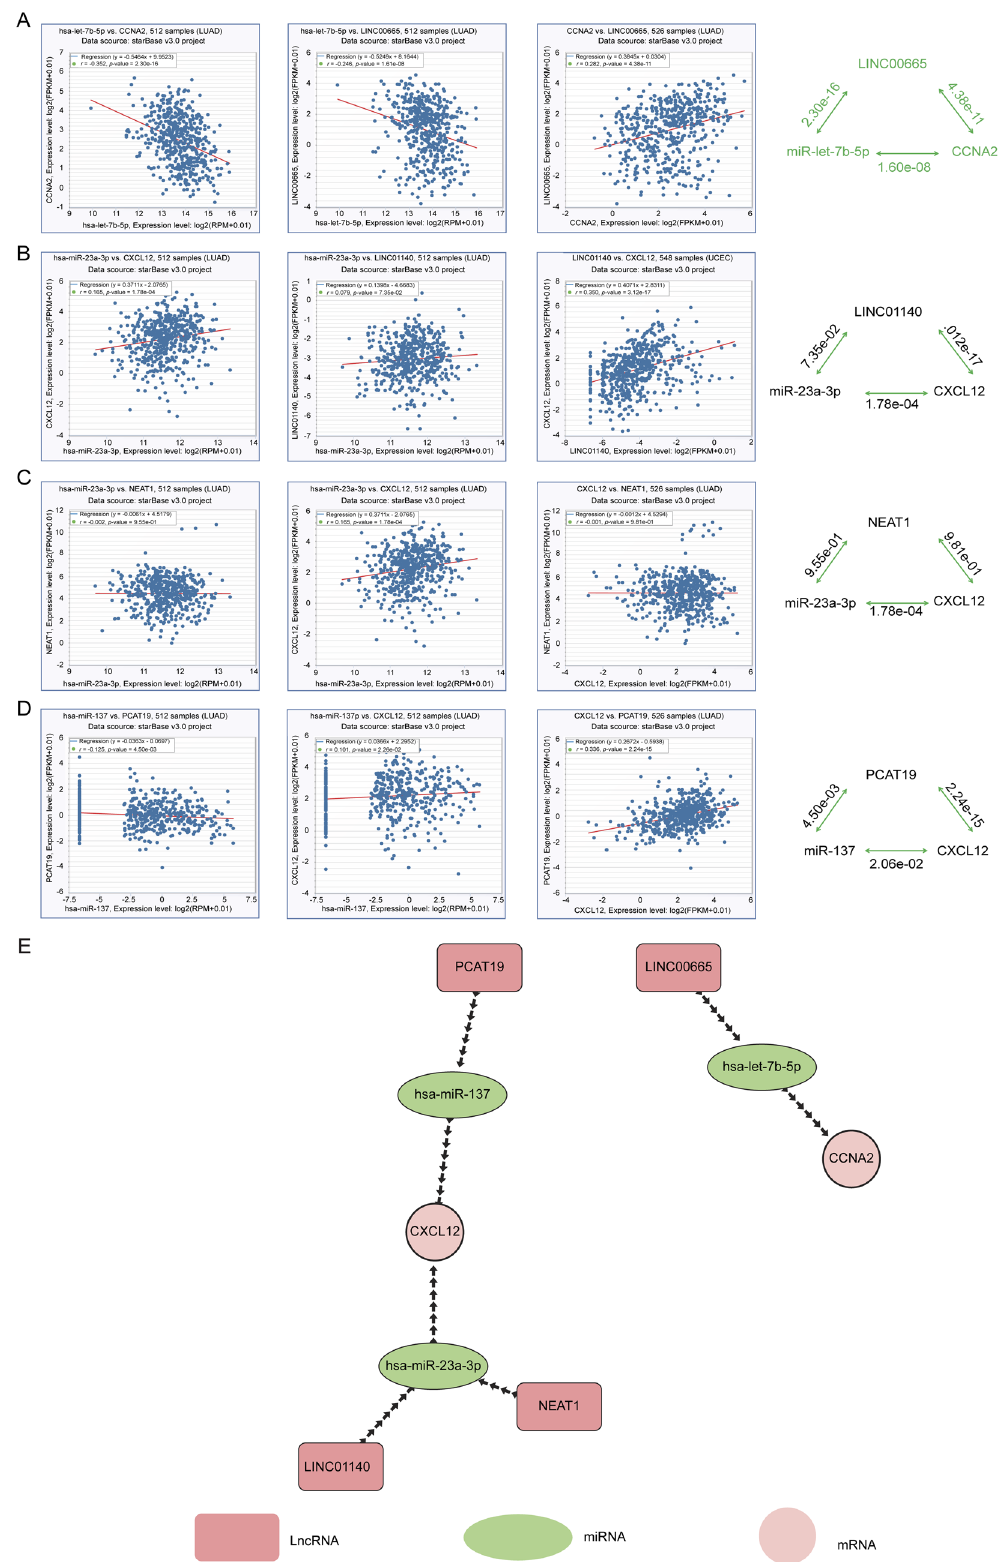
Figure 7. Construction of the lncRNA–miRNA–mRNA regulatory network in LUAD. Correlations within mRNA, miRNA, and lncRNA using the starBase database ( A – D ). ( E ) Novel mRNA–miRNA–lncRNA competing endogenous RNA (ceRNA), triple-regulatory network associated with the prognosis of